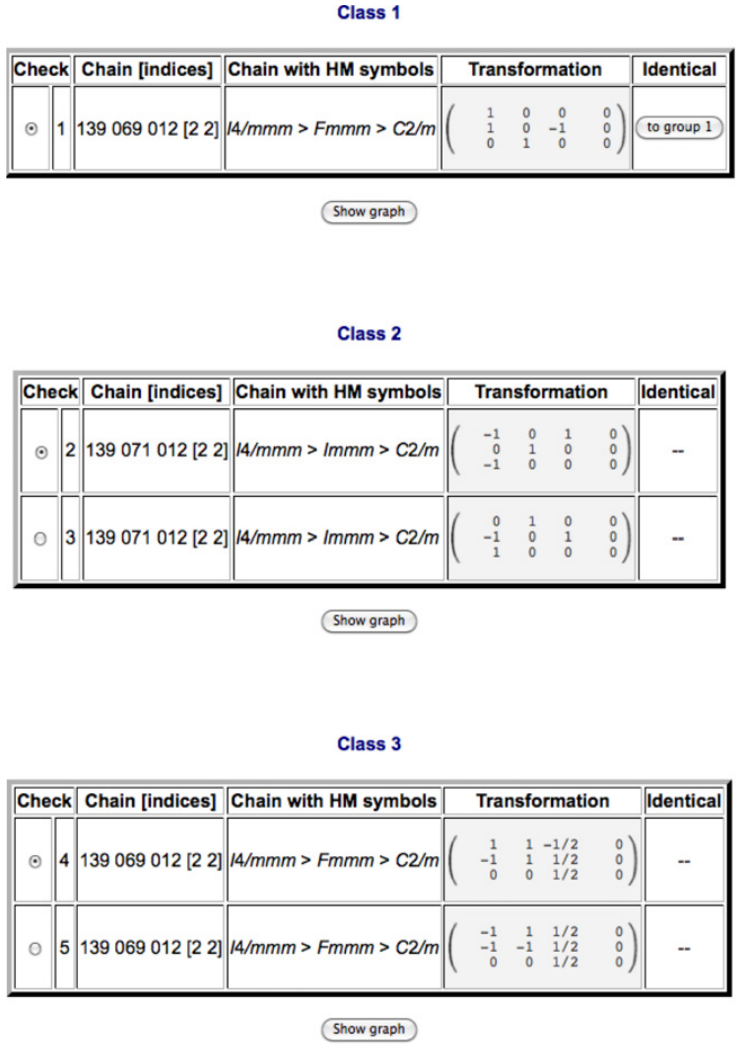
Figure 3. Output of CELLSUB indicating the different conjugacy classes of subgroups of I 4 /mmm of type C 2 /m with index i k =